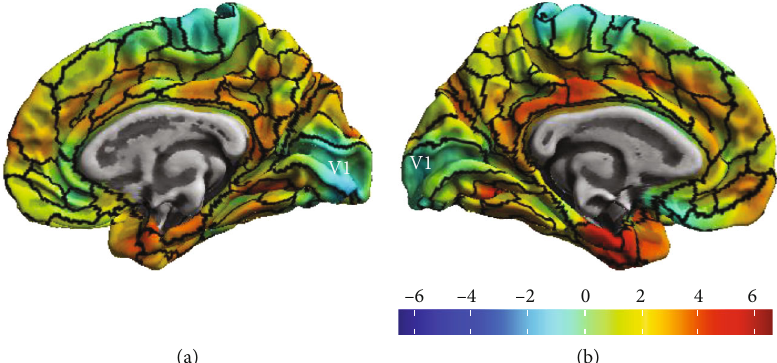
Figure 1: Resulting cortical thickness map between HC and AD groups, with the representation of the V1 area: (a) right hemisphere, (b) left hemisphere.